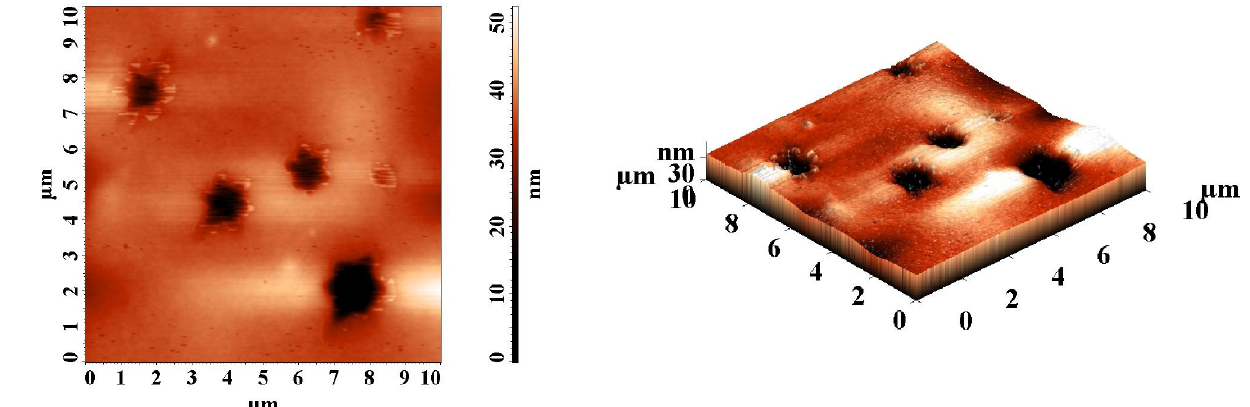
Figure 14. Topographical AFM image of a PMMA/ABM 2 films after UV